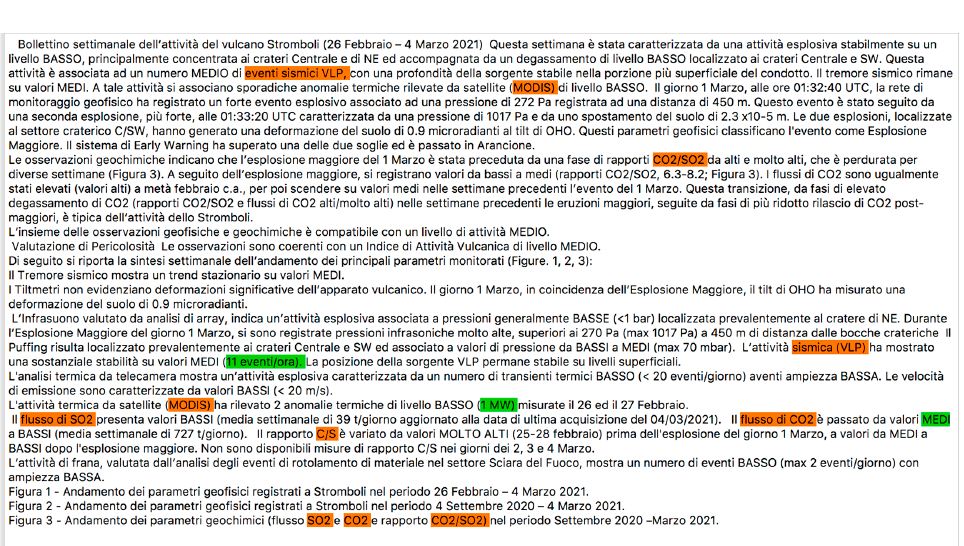
Figure 4. Tagging: orange highlight is used for parameters and green for values/scores, when matched. The original text of the input volcanological bulletin is in Italian language.